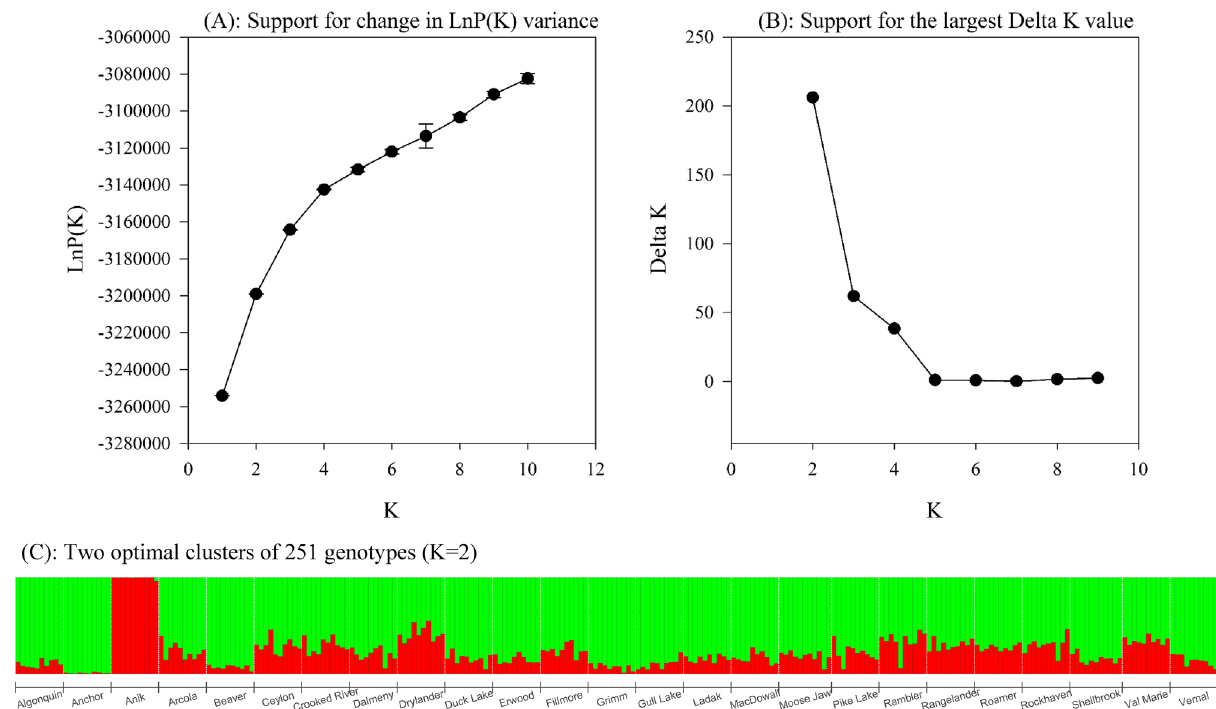
Figure 1. Genetic backgrounds inferred by STRU CTU RE using 19,853 SNPs of 14 alfalfa populations from long-term grazing sites sampled across four soil zone of Saskatchewan Canada and 11 alfalfa cultivars released between 1926 and 1980. ( A ): Support for change in LnP(K) variance; ( B ): Support for the largest Delta K value; ( C ): Two optimal clusters of 251 genotypes (K =